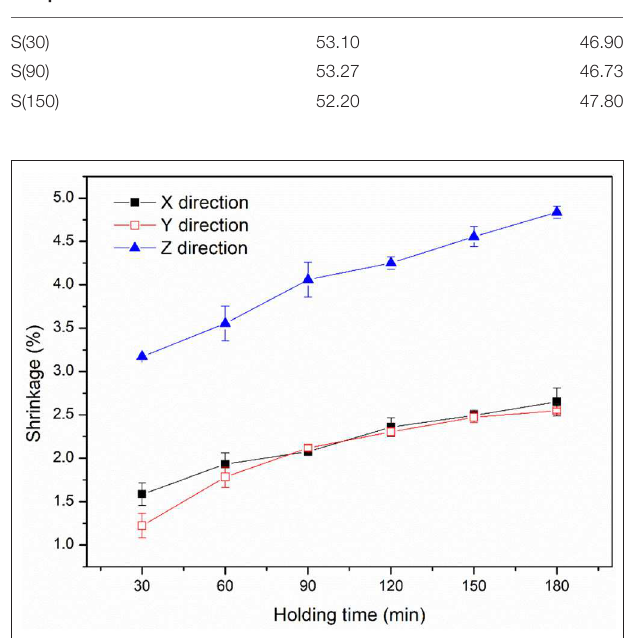
FIGURE 11 | Shrinkage of alumina ceramic sintered with different holding times.